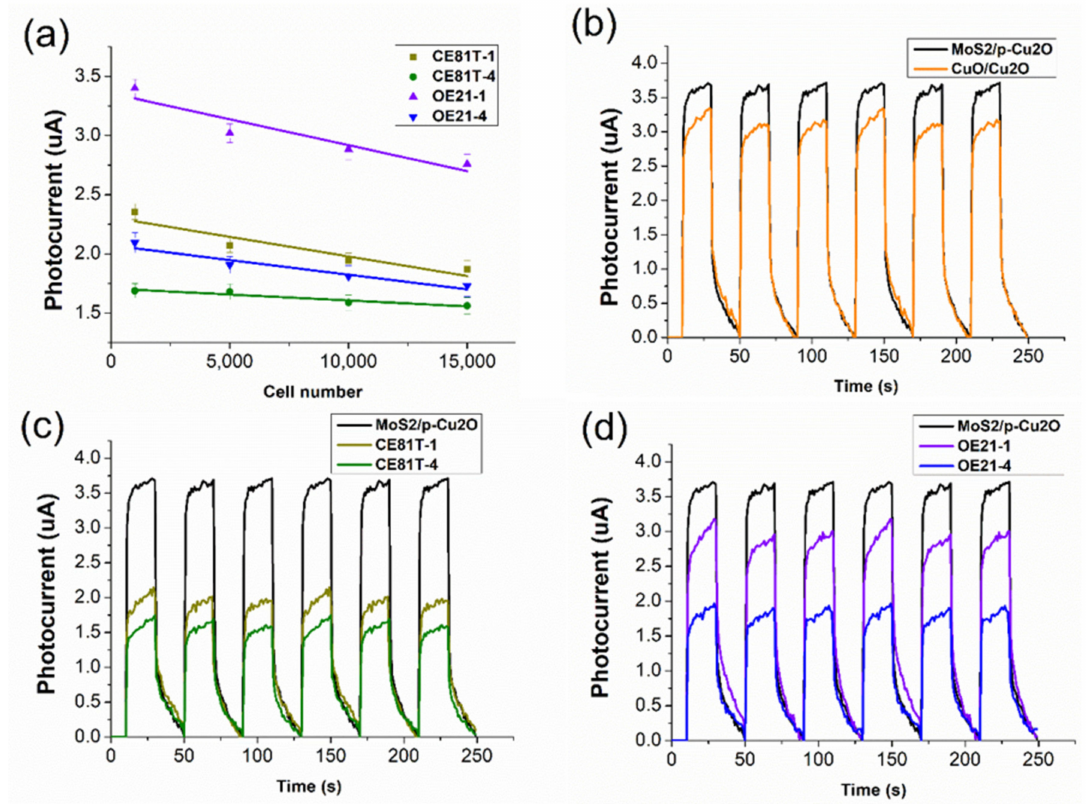
Figure 7. Photoelectrochemical response of esophageal squamous cell carcinoma: ( a ) P-type element modulates the linear relationship between the number of four cancer cell lines and light response analysis. ( b ) Comparison of light response analysis between MoS 2 /Cu 2 O and original elements; ( c ) MoS 2 /Cu 2 O and CE81T-1 and CE81T-4; and ( d ) MoS 2 /Cu 2 O, OE21-1, and